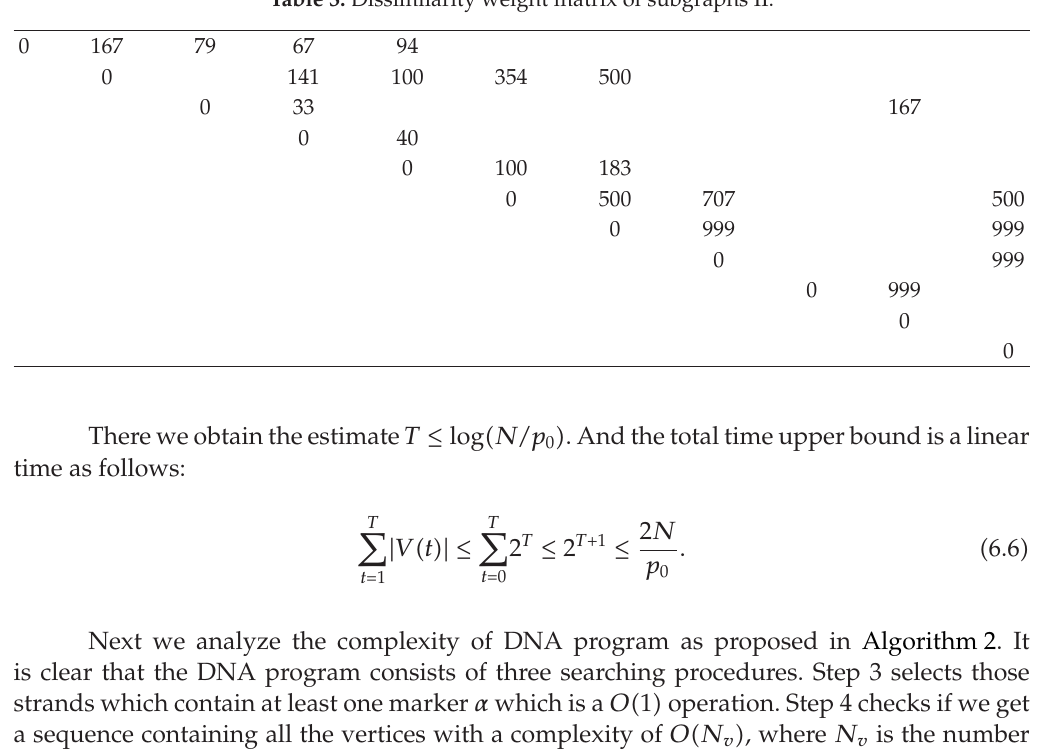
Table 3: Dissimilarity weight matrix of subgraphs